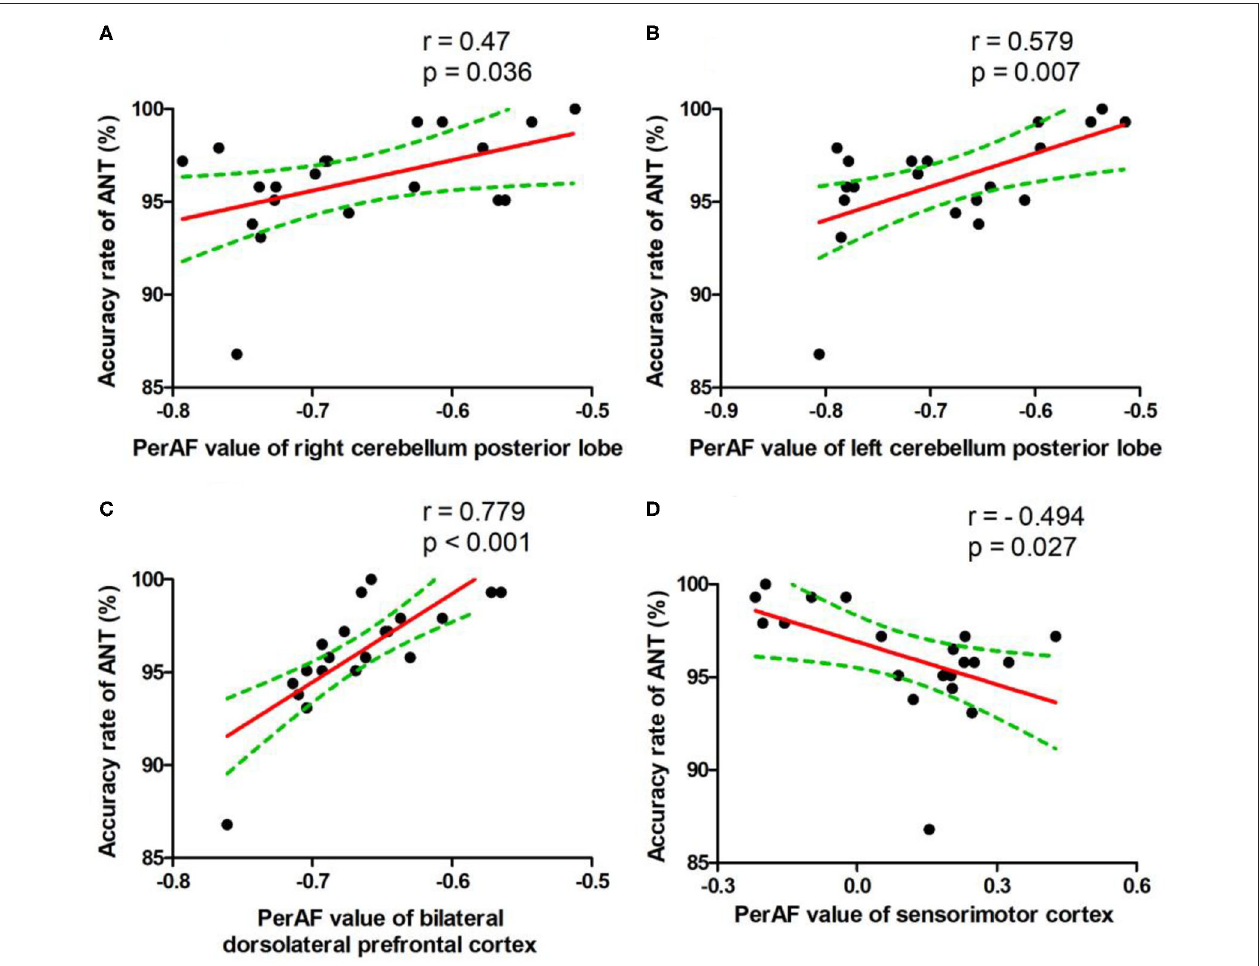
FIGURE 5 | Pearson’s correlation. Correlations were found between accuracy rate of ANT and bilateral cerebellum posterior lobe (Right, A ; Left, B ), bilateral dorsolateral prefrontal cortex (C) , or bilateral sensorimotor cortex (D) . PerAF, percent amplitude of fluctuation; ANT, attention network